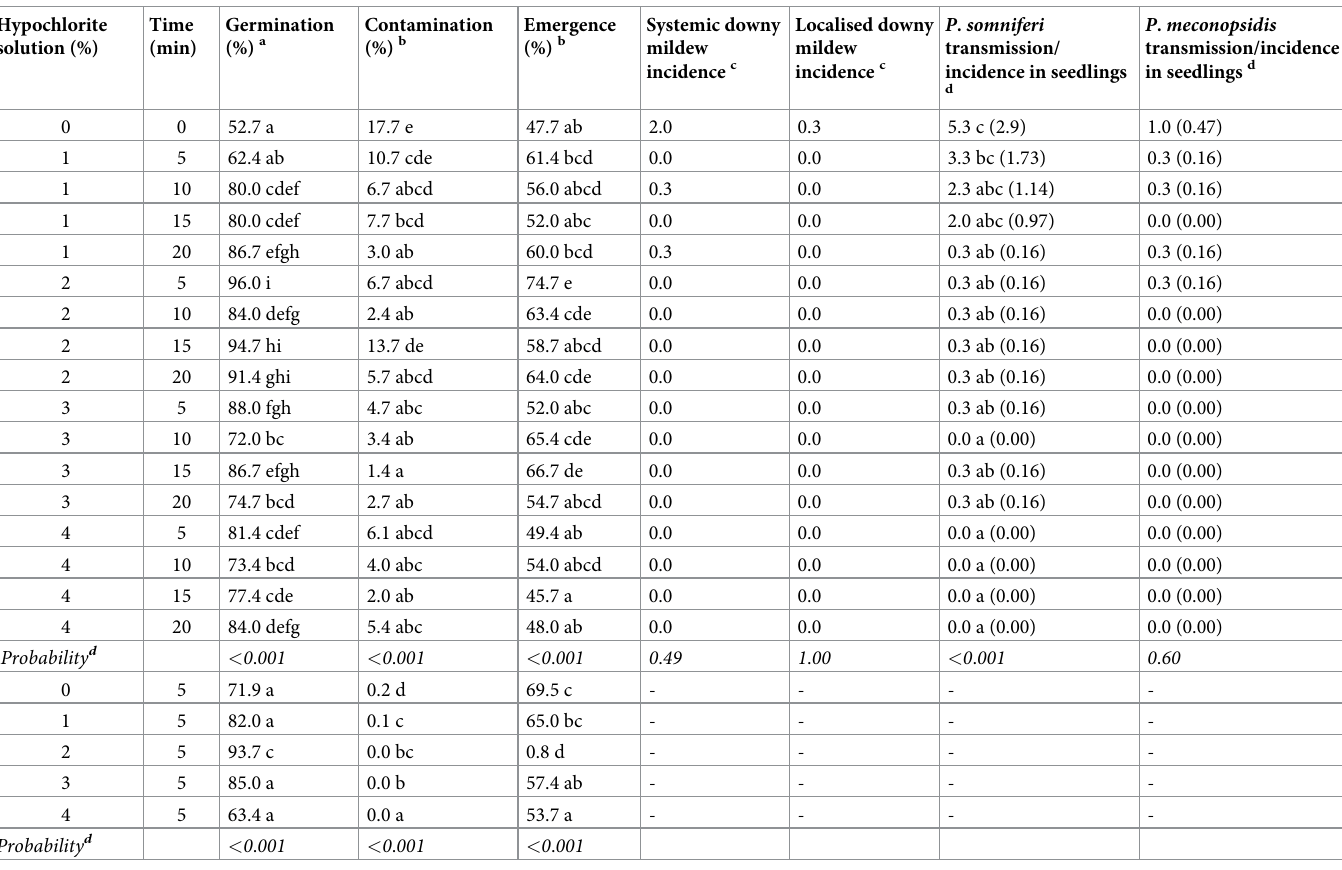
Table 2. The effect of hypochlorite solution treated at various concentration and time on the opium poppy seeds. The mean proportion of germination, emergence, contamination and disease incidences were estimated using logistic regression model. Significant differences were grouped using HSD mean separation. Hypochlorite Time solution (%)